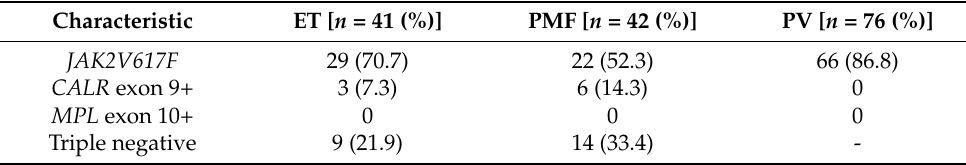
Table 2. Prevalence of JAK2 V617F , CALR , and MPL gene mutations.